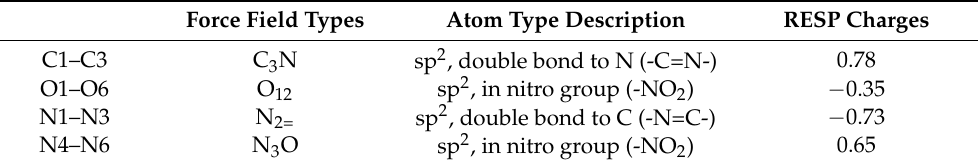
Table 1. Atom names, force field parameters, and RESP charges taken from COMPASS for prediction of crystal